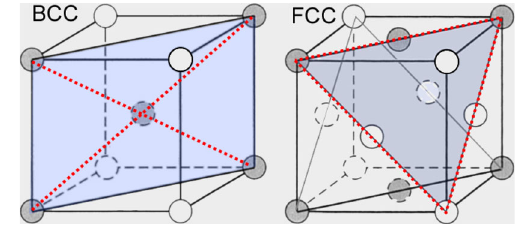
1. (Color) Comparison between BCC and FCC crystal structures. Examples of slip planes are shaded, and slip direc- tions identified with dotted